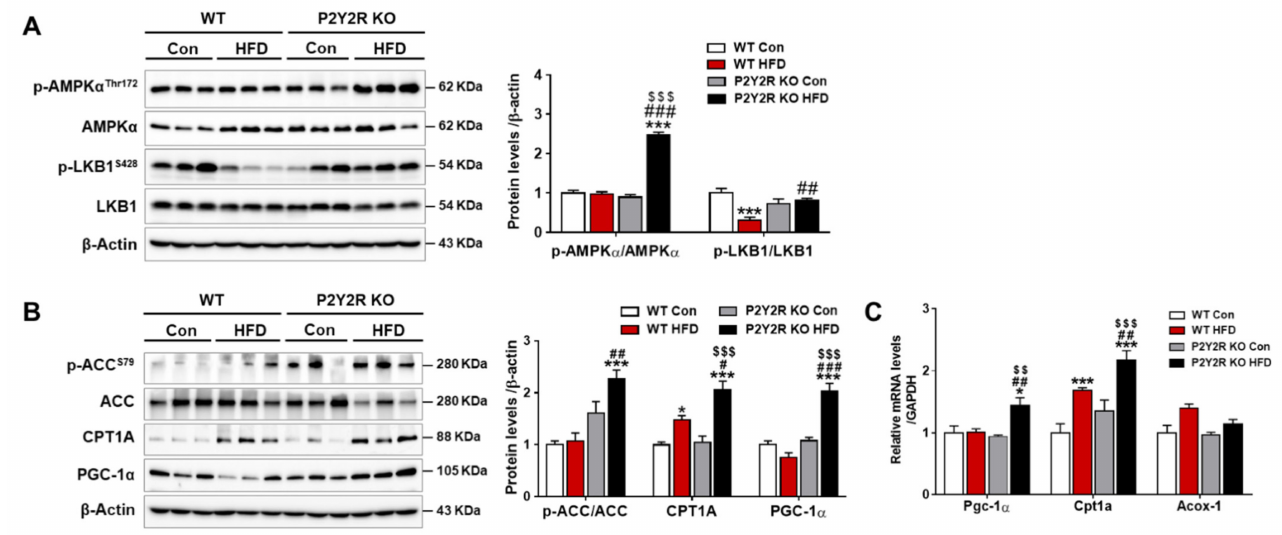
Figure 4. P2Y2R deficiency enhances mitochondrial fatty acid β -oxidation in HFD-fed mice. ( A , B ) Liver tissues were lysed to perform western blot analysis, and the protein levels of p-AMPK, p-LKB1, p-ACC, PGC-1 α , CPT1A, and β -actin (a loading control), were examined. Quantitative analysis of each protein was shown ( n = 5). ( C ) The mRNA expression of genes involved in fatty acid β -oxidation was determined by real-time PCR analysis. Relative mRNA levels were normalized to those of GAPDH ( n = 3–5). Data are presented as the mean ± SEM. One-way ANOVA was used for statistical analysis followed by Bonferroni’s multiple comparison test. * p < 0.05, *** p < 0.001 vs. WT control mice; and # p < 0.05, ## p < 0.01, ### p < 0.001 vs. WT HFD mice; and $$ p < 0.01, $$$ p < 0.001 vs. KO control